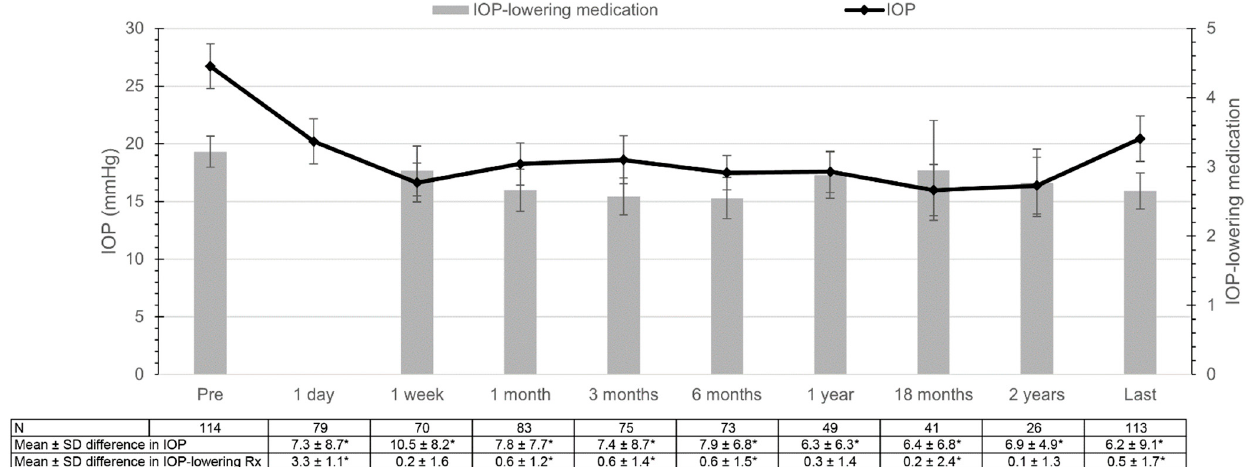
Figure 1. Mean intraocular pressure (IOP; line) and number of IOP-lowering medications (bars) with corresponding 95% confidence intervals, using a linear mixed model for IOP and paired t-tests for IOP-lowering medications. The “last” time interval had a median (interquartile range) follow-up of 11.99 (5.8—22.9) months. * = p < 0.05; IOP = intraocular pressure; SD = standard deviation; Rx = medications.